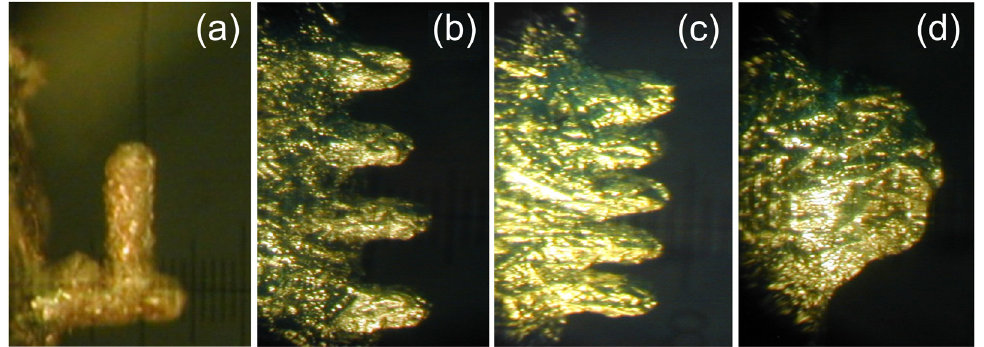
Figure 10. Examples of microstructures grown on liquid metal surfaces by irradiation with the second harmonics of Nd:YAG laser in air at F 0 = 3.2 J/cm 2 . ( a ) A branched structure grown on a liquid gallium target at the ambient temperature T 0 = 30 °C. The parent microtower (horizontal) was grown with 250 laser pulses and the branch was formed by laser beam focused perpendicularly to the parent microtower wall during the next 250 pulses. ( b )–( d ) Microtower “fences” grown on Wood’s metal at T 0 = 250 °C with different spatial separations of the irradiation spots. The distances between the spot centers are approximately two spot diameters ( b ), one spot diameter ( c ), and spot radius ( d